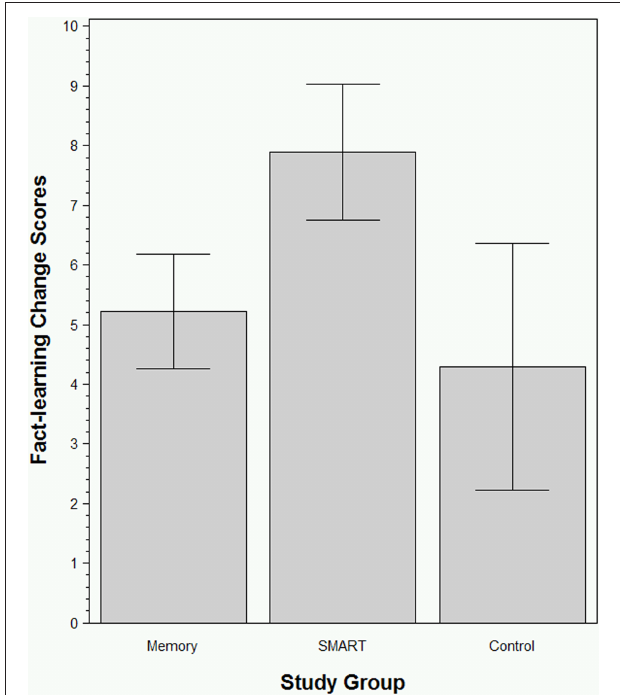
FiGuRe 2 | Changes in fact-learning scores after training for each group. Groups: Memory, Rote Memory Training Group; SMART, Strategic Memory and Reasoning Training Group; Control, Teen Brain Information